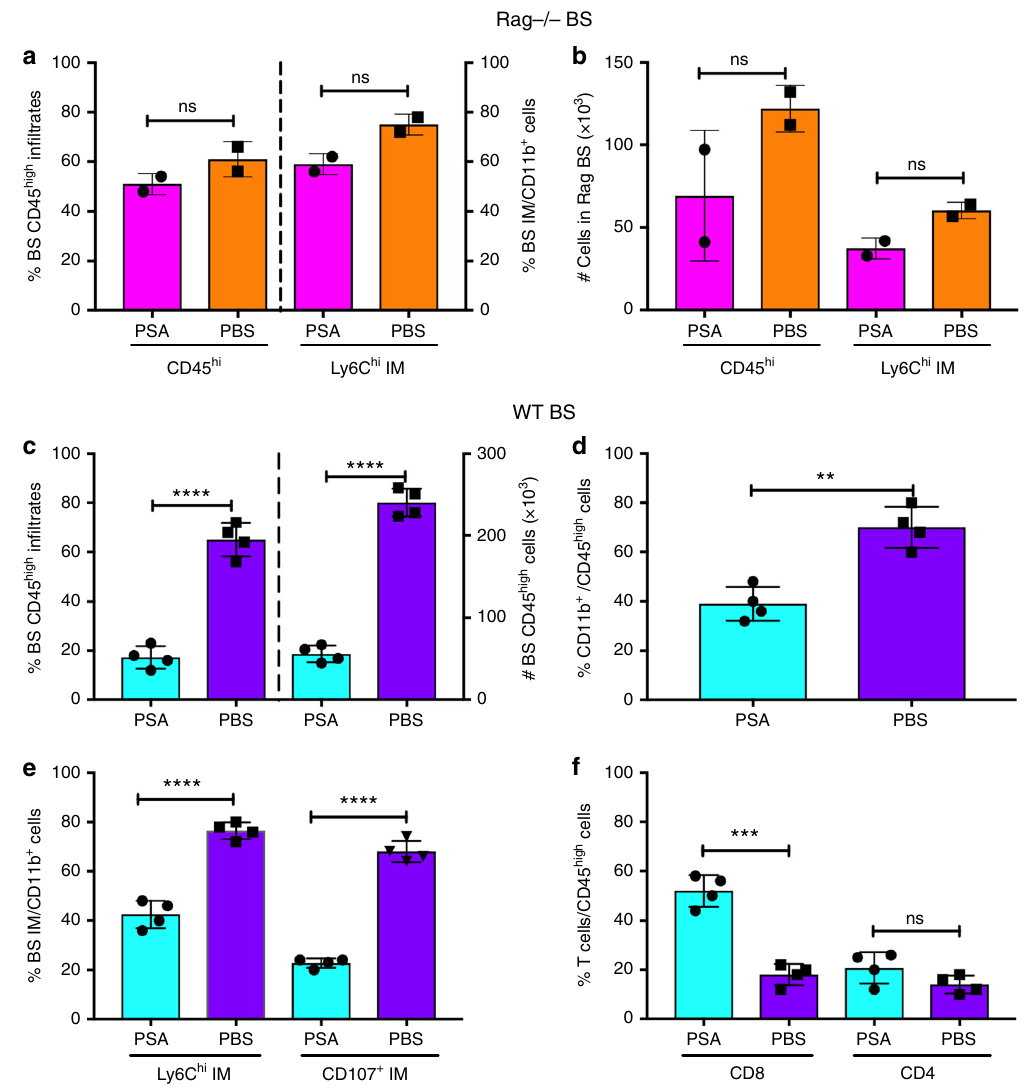
Fig. 2 PSA reduces CNS in fl ammation in HSV-infected WT but not Rag mice. a % and b total numbers (#) of CD45 high leukocytes and CD45 high Ly6C high in fl ammatory monocytes (IM) in fi ltrating the brainstem (BS) of Rag mice. c % (left y -axis) and # (right y -axis) in fi ltrating CD45 high leukocytes in the BS of WT mice. d % CD11b + cells within BS in fi ltrating CD45 high cells; e % Ly6C high and CD107 + IM within the CD11b + population; f % CD4 + and CD8 + T cells within CD45 high cells in the BS of WT mice. Data compiled from 2 to 4 experiments with n = 6 – 8/group at day 6 pi. All data show mean ± SEM. *** p < 0.0005, **** p < 0.0001, ns: not signi fi cant, as determined by two-tailed Student's t